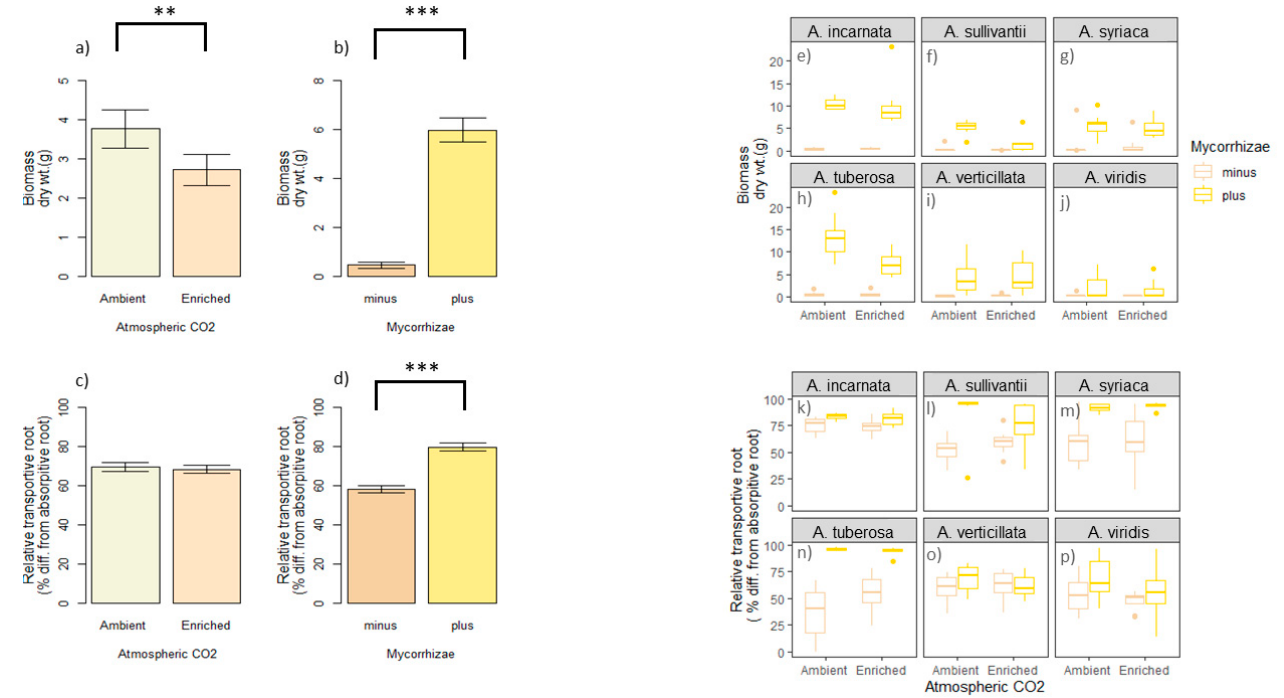
Figure 2. The outcome of mycorrhizae and CO2 (predictors) on explanatory variables (i.e., relative transportive root and biomass). Relative transportive root response is the percent difference in transportive root versus absorptive root diameter. Biomass response is dry weight in grams. The main effect of predictors on biomass are shown in A , B . The main effect of the predictors on root response are shown in C , D . Asclepias spp. biomass response to CO2 and mycorrhizae (i.e., predictors) are shown in E – J ). Asclepias spp. root response to CO2 and mycorrhizae (i.e., predictors) are shown in K – P . Error bars are standard error in A – D . Significant codes: ‘***’ p < 0; ‘**’ p < 0.001